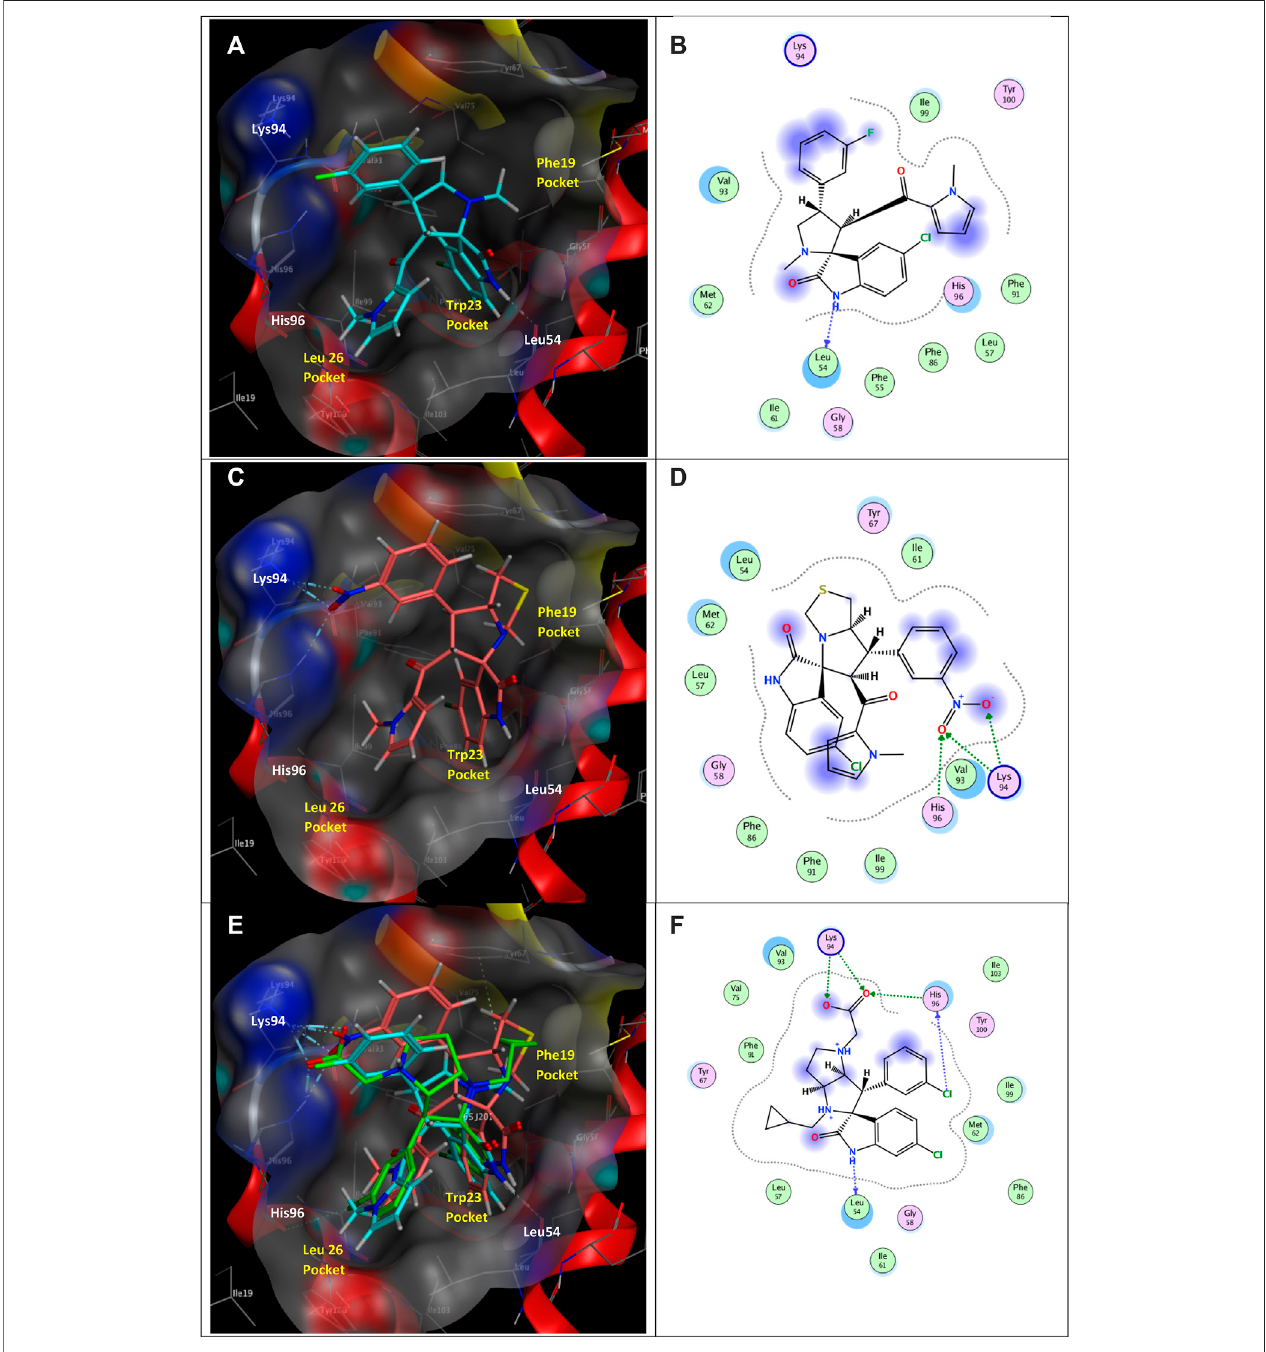
FIGURE15|(A) Three-dimensional(3D)bindingmodeof 2a (cyansticks), (B) 2Dbindingmodeof 2a , (C) 3Dbindingmodeof 2b (darkpinksticks), (D) 2Dbinding mode of 2b , (E) overlay of 2a and 2b with the co-crystalized human homolog of mouse double minute 2 (MDM2) inhibitor (green sticks), (F) 2D binding mode of the co- crystalized ligand 6SJ in MDM2 (PBD ID: 5LAW) (Gollner et al., 2016). The Leu26, Trp23, and Phe19 pockets of p53 are indicated as well as the key hydrogen bond interactions with MDM2 Leu54.